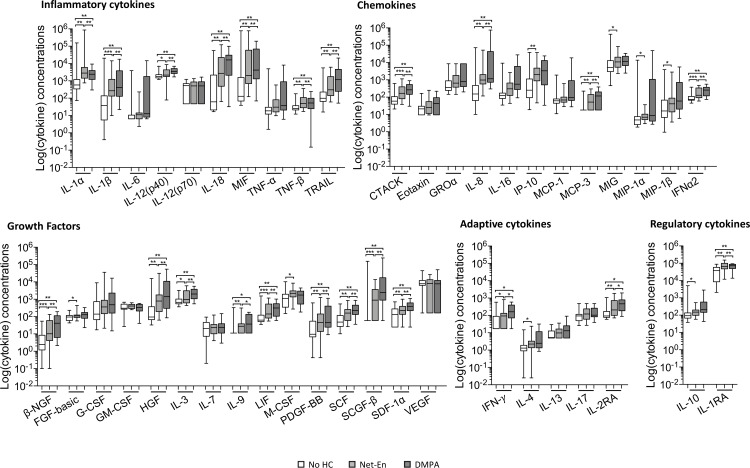
Comparison of cytokine concentrations in adolescents not using HC (white bars), those using Net-En (light grey bars) and those using DMPA (dark grey bars).Mann Whitney U-tests were used to compare groups and a p ≤0.05 was considered significant, after adjusting for multiple comparisons. *p<0.05; **p<0.01 and ***p<0.001. The box-and-whisker plots show the median, IQR and 5–95% range.